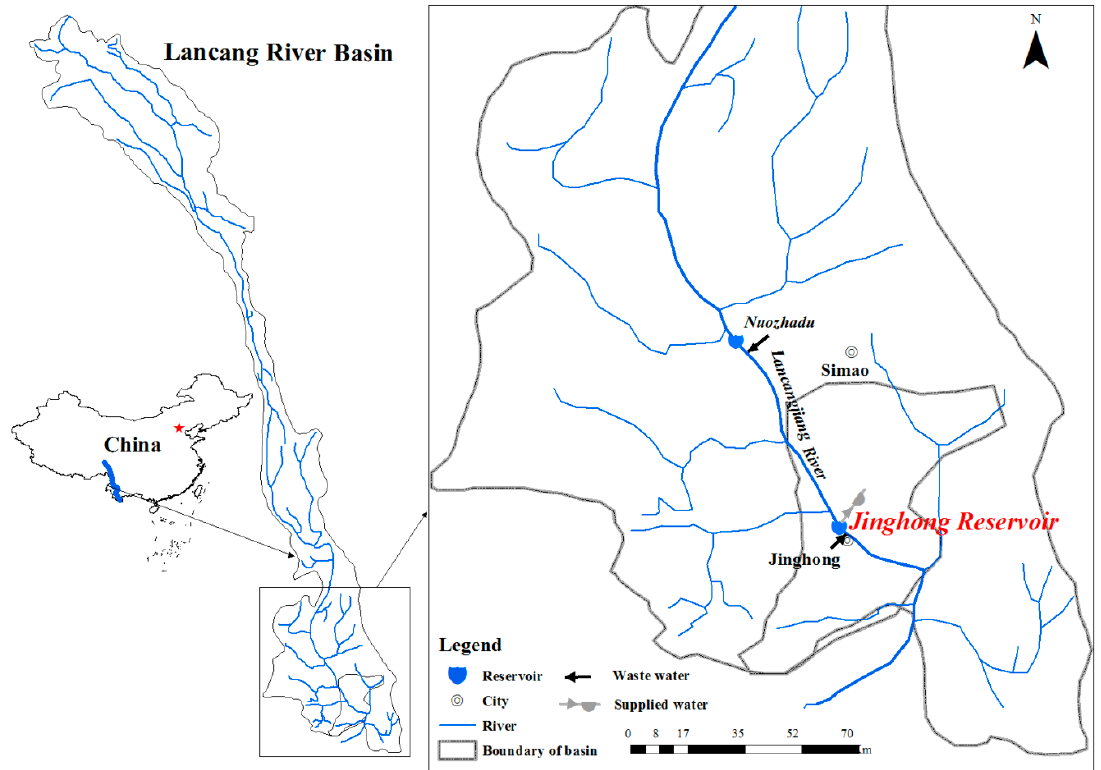
Figure 2. Location of study area.